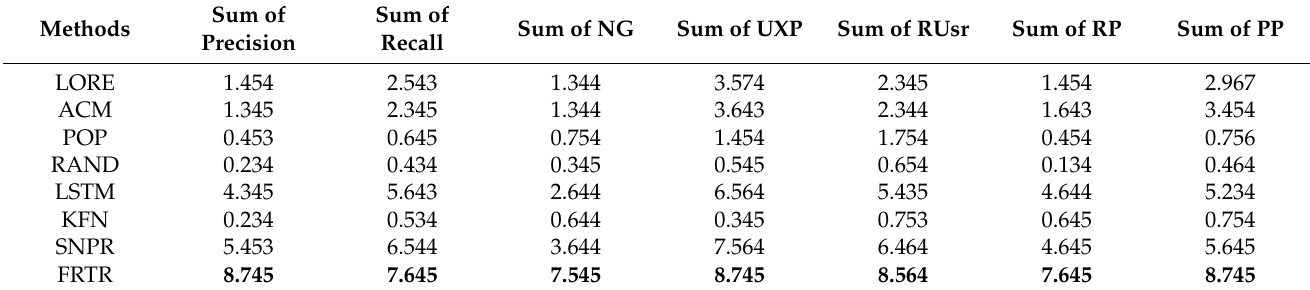
Table 6. Represents the experimental outcomes for New York after Sru = 4, Sn = 3, Ns =